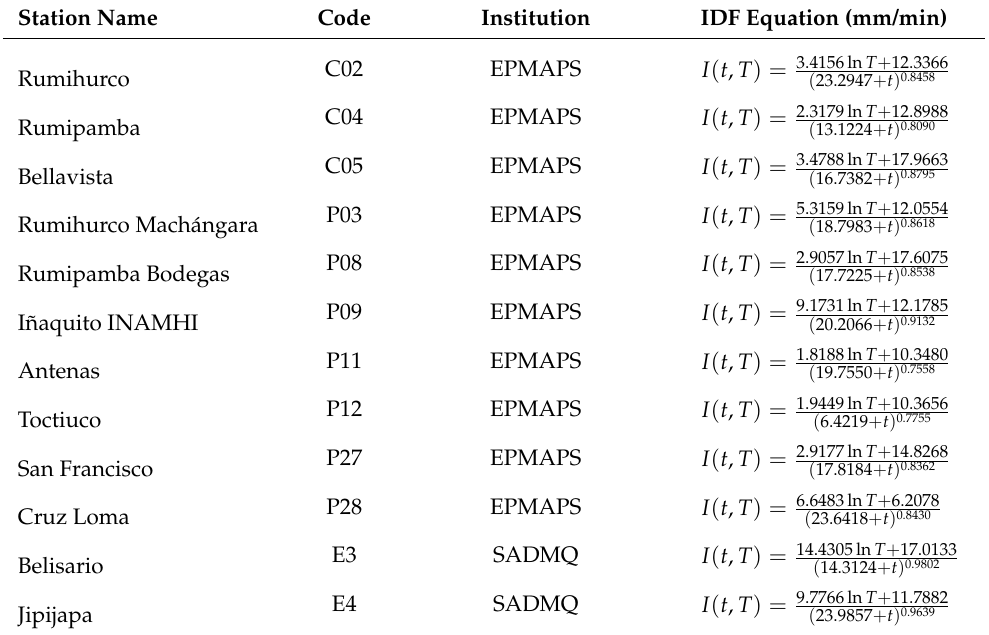
Table A1. IDF Equations for stations located in El Batán